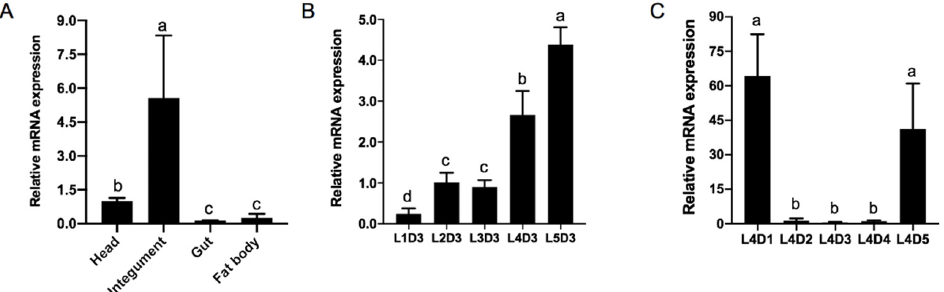
Figure 2. The expression of HcCht5 in H. cunea by RT-qPCR. ( A ) The expression of HcCht5 in different tissues of day 3 of the fifth instar larvae. ( B ) The expression of HcCht5 on the third day of each larval stadium (L1D3–L5D3). ( C ) The expression of HcCht5 on each day of the fourth larval stadium (L4D1–L4D5). Error bars represent the standard error of the calculated means based on three biological replicates. Different letters above the bars represent significant differences in the HcCht5 expression between the samples (one-way analysis of variance followed by Tukey’s test, p < 0.05).